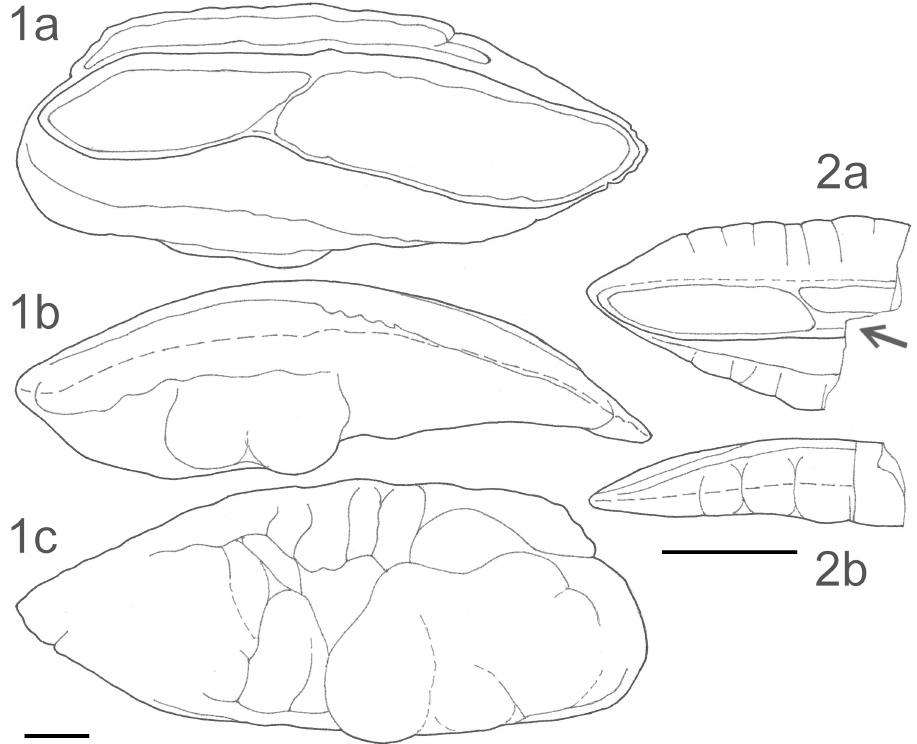
Figure 12. ( 12.1a – c ) Trisopterus capelanus otolith from Salir do Porto, Portugal, TL 250 mm, coll. P. Gaemers; ( 12.2a , b ) Incomplete fossil Neocolliolus esmarkii otolith, off southern Morocco (28°56 ′ 57 ′′ N, 12°30 ′ 56 ′′ W, depth 524 m), coll. P. Gaemers; ( 12.1a , 12.2a ) Inner surfaces, ( 12.1b , 12.2b ) Ventral views, ( 12.1c ) outer surface; the arrow points to the partially preserved, ventrally situated collum. The bars represent one mm.